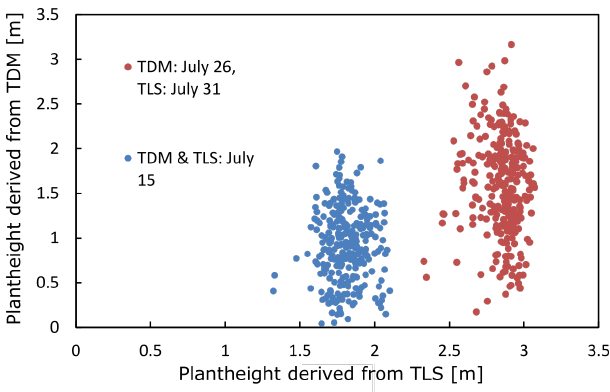
Figure 9. All pixel-wise extracted plant heights of the maize field at two different dates. For estimation of the TDM heights the mean of HH- and VV-Polarisation plant height was taken (each n =